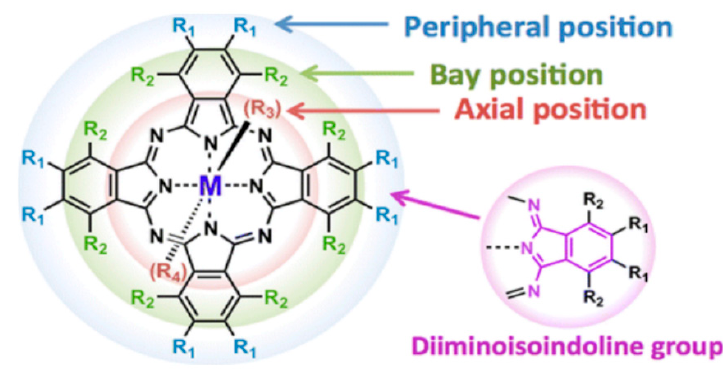
Figure 1. Phthalocyanine molecule.